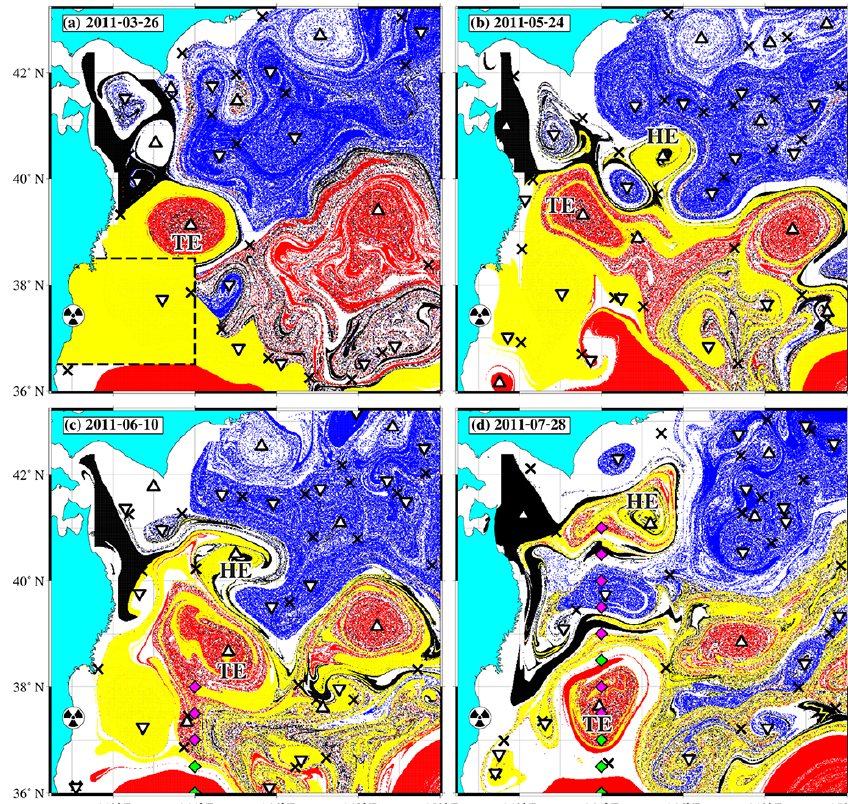
Figure 2. The Lagrangian maps show evolution of the Tohoku eddy (TE) from after the accident to the days of its sampling and the origin of waters in its core and at the periphery. The red, black and blue colors specify the tracers which came for 2 years in the past to their places on the maps from the Kuroshio, Oyashio and Tsushima currents, respectively, more exactly, from the corresponding line segments shown in Fig. 1a. The yellow color marks the Lagrangian particles coming from the area around the FNPP in Fig. 1a (shown in Fig. 2a by the dashed line), after the day of the accident on 11 March 2011. The TE was sampled on 10 and 11 June 2011 by Buesseler et al. (2012) along the transect 35.5–38 ◦ N, 144 ◦ E shown in (c) and at the end of July 2011 by Kaeriyama et al. (2013) along the transect 35 ◦ N–41 ◦ N, 144 ◦ E shown in (d) . The locations of stations with surface seawater samples (collected by Buesseler et al., 2012 and Kaeriyama et al., 2013) with measured radiocesium concentrations at the background level are indicated by the green diamonds. Stations where the concentrations were measured to be much higher are marked by the magenta